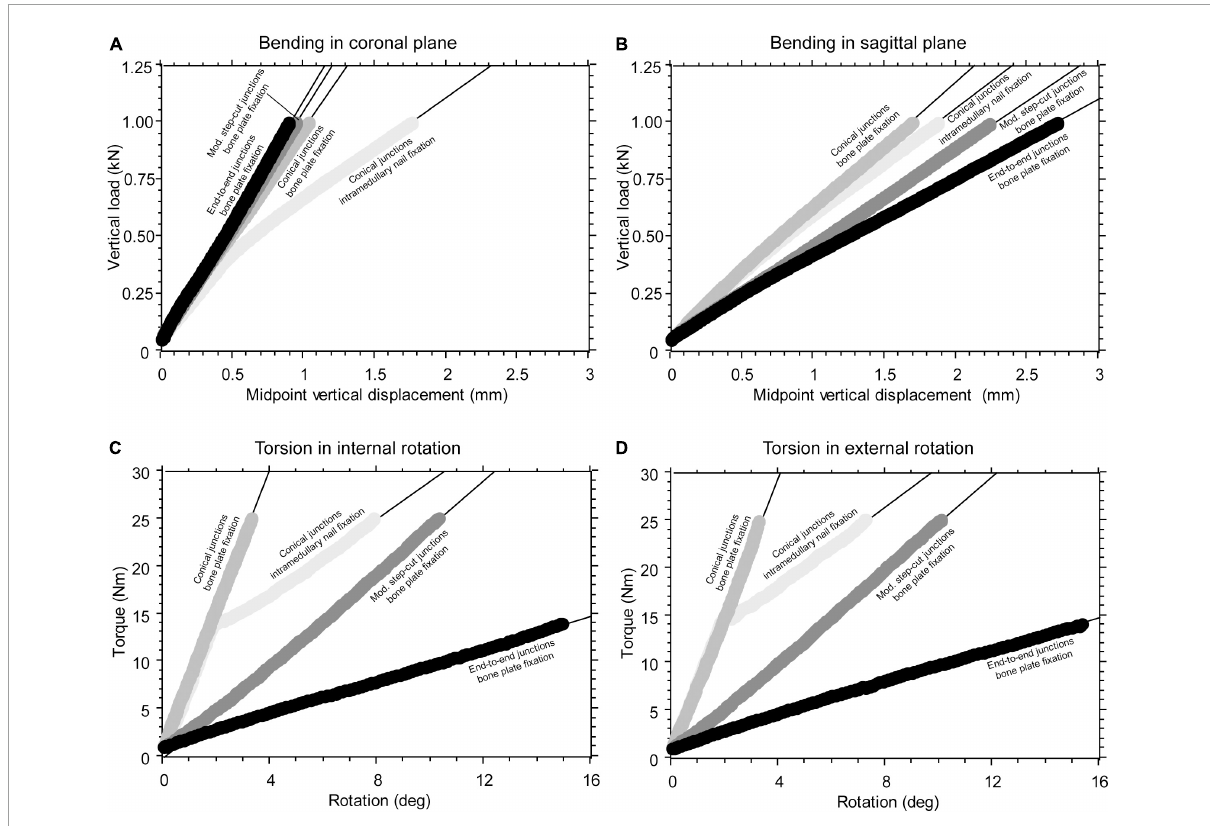
FIGURE3 (A) Example of force-displacement curve collected during construct bending in the coronal plane generating tension on the lateral side. (B) Example of a force-displacement curve collected during construct bending in the sagittal plane, generating tension on the anterior side. (C) Example of a torque-rotation curve collected during construct torsion, causing intra-rotation of the proximal femur. (D) Example of a torque-rotation curve collected during construct torsion, causing extra-rotation of the proximal femur.